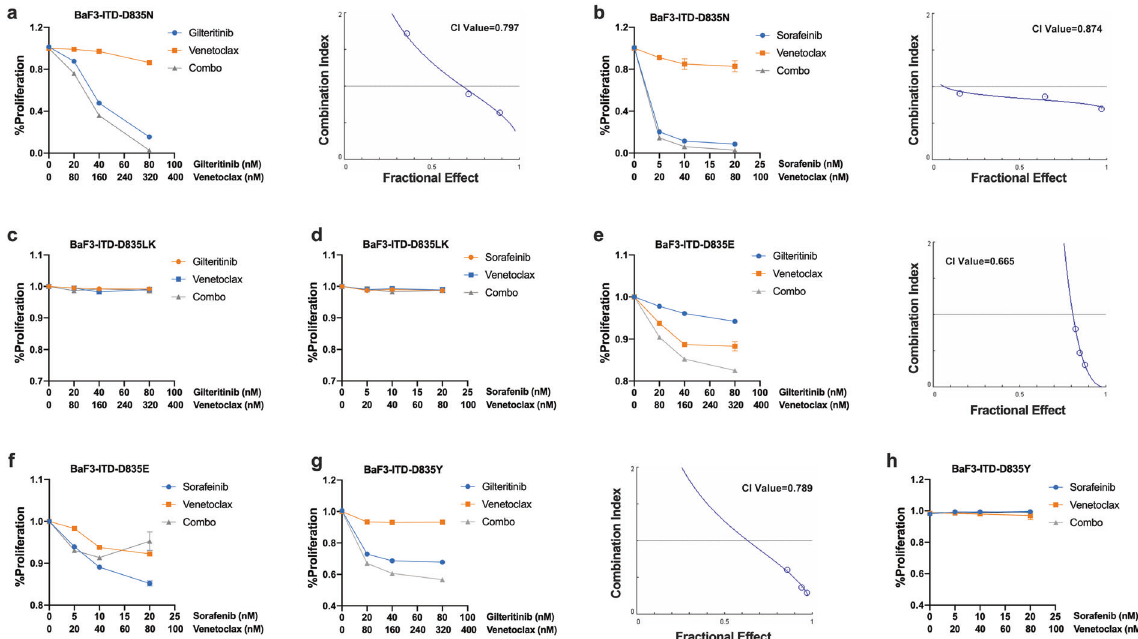
Fig. 6 The effects of FLT3 TKI (Gilteritinib or Sorafenib) and/or Venetoclax treatment in BaF3 cells with FLT3 AL point mutations. In all, 48 h MTT assay of a BaF3 D835N, c BaF3 D835L + K, e BaF3 D835E, and g BaF3 D835Y cells treated with indicated doses of Gilteritinib and/or Venetoclax. In all, 48 h MTT assay of b BaF3 D835N, d BaF3 D835L + K, f BaF3 D835E, and h BaF3 D835Y treated with indicated doses of sorafenib and/or